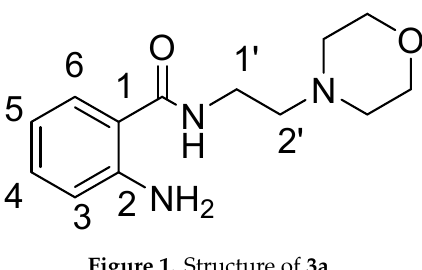
Figure 1. Structure of 3a .